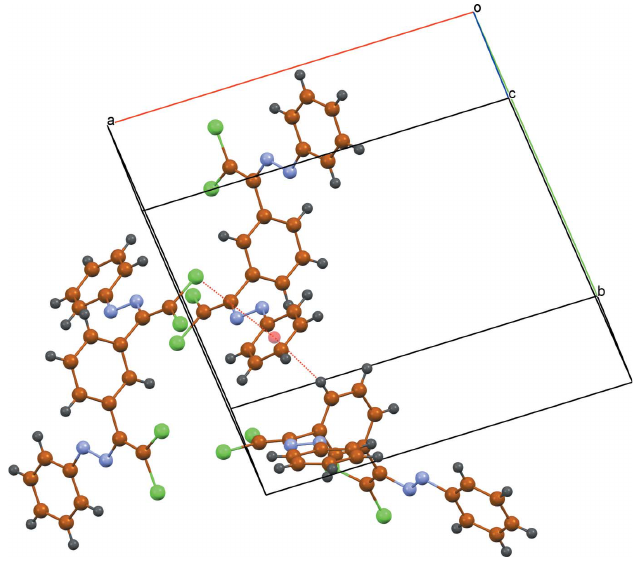
Figure 2 A fragment of the molecular packing showing the C—H (cid:2)(cid:2)(cid:2) (cid:2) and C—